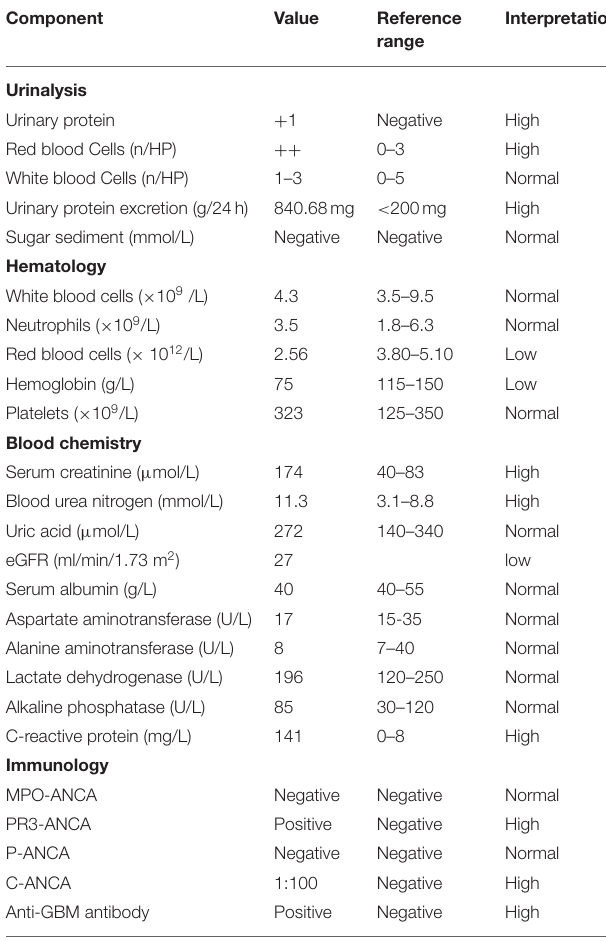
TABLE 1 | Laboratory characteristics at time of kidney